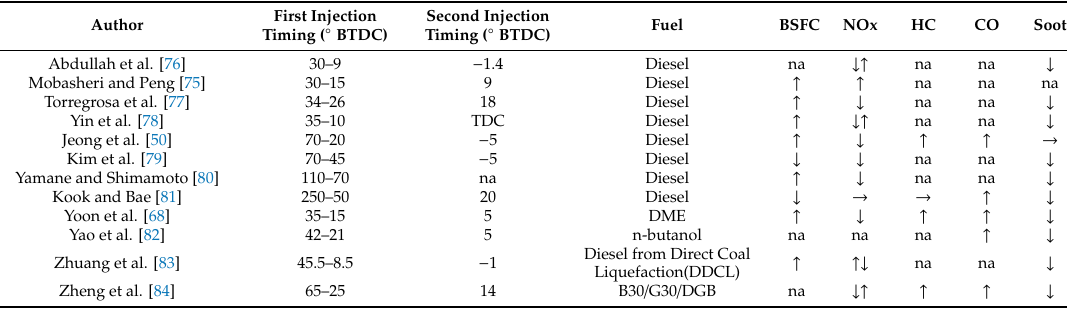
Table 4. Variation of performance and emissions after advancing the first injection timing